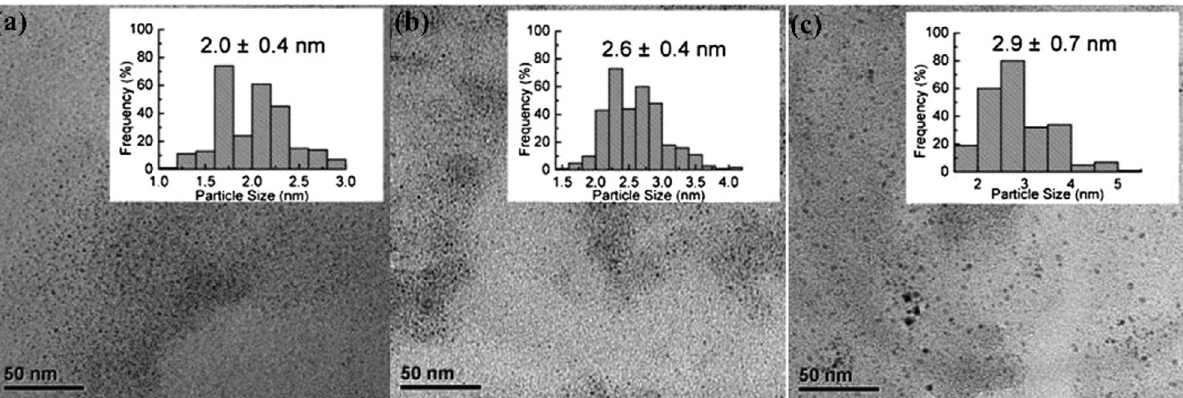
Figure 4: TEM images of the Pt NPs synthesized at ( a ) 30°C, ( b ) 60°C, and ( c ) 90°C when the Cacumen platycladi percentage and initial Pt ( II ) concentration were 50% and 1 mM, respectively ( reprinted from ref. [ 12 ] , copyright 2020, with permission from Elsevier ) .